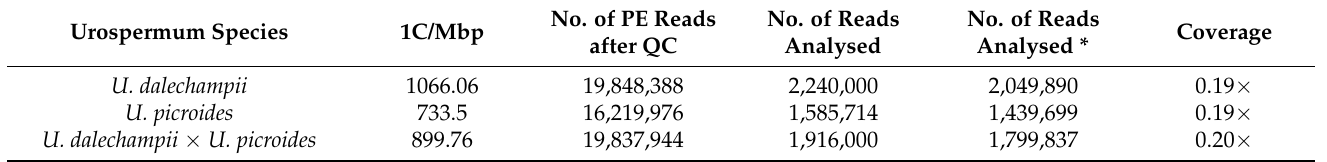
Table 3. Genome skimming details of the three Urospermum taxa studied.